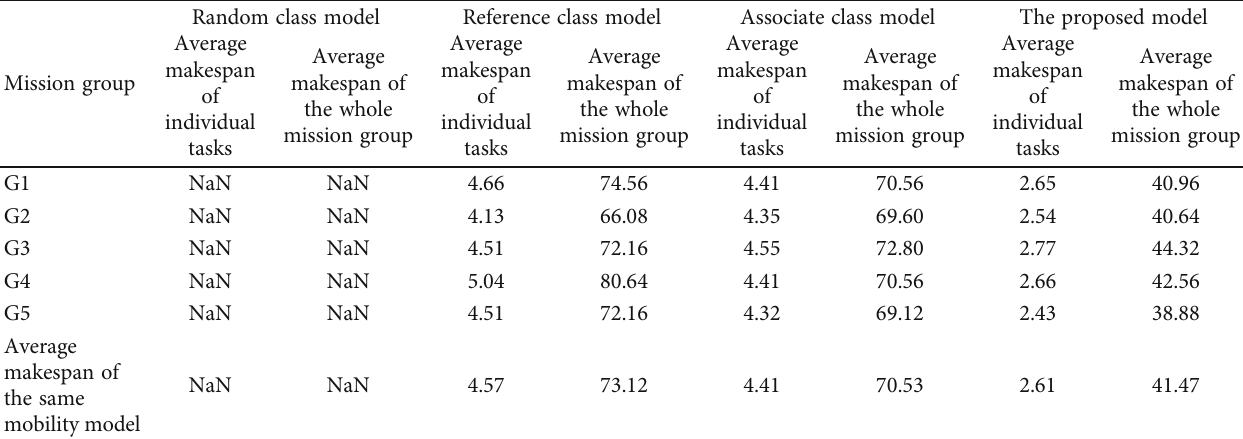
Table 8: Average makespans of individual tasks and the whole mission group with di ff erent moving strategies (unit: ms).